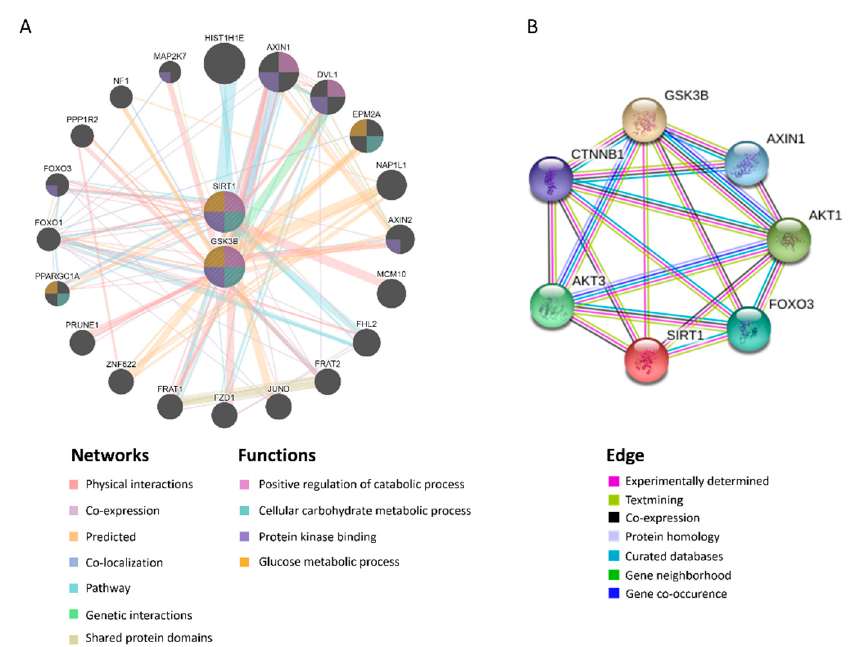
Figure 5. GSK3 β is closely associated with SIRT1. Predicted protein–protein interactions (PPI) between GSK3 β and SIRT1 using STRING and GeneMANIA servers. ( A ) Predicted functional partners are shown after considering physical interaction (67.64%), co-expression (13.5%), predicted (6.35%), co-localization (6.17%), pathways (4.35%), genetic interactions (1.40%), and shared protein domains (0.59%). The mutual functions of GSK3 β and SIRT1 include positive regulation of the catabolic process, cellular carbohydrate metabolic process, protein kinase binding, glucose metabolic process. ( B ) The edges are determined by experimentally determined, textmining, co-expression, protein homology, curated databases, gene neighborhood, gene co-occurrence.